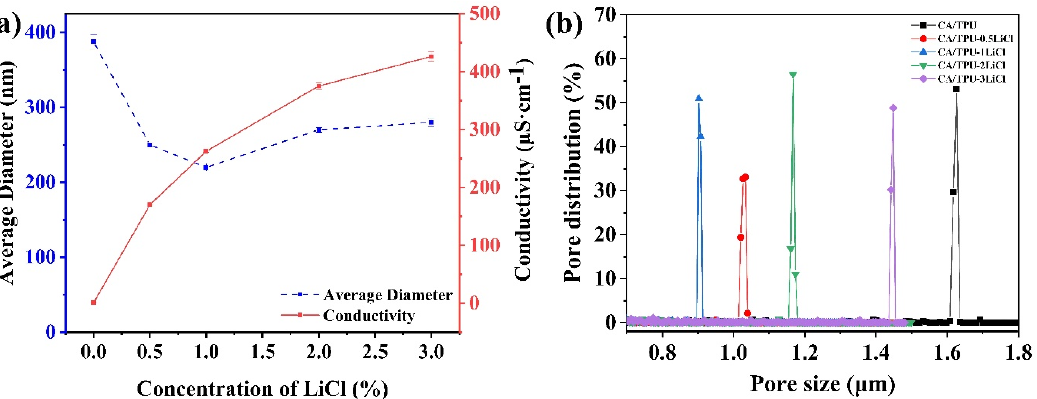
Figure 3. ( a ) Average diameter of the CA/TPU ‐ xLiCl fibers and conductivity of the spinning solutions with different LiCl concentrations; ( b ) Pore size distribution of the CA/TPU ‐ xLiCl membranes.